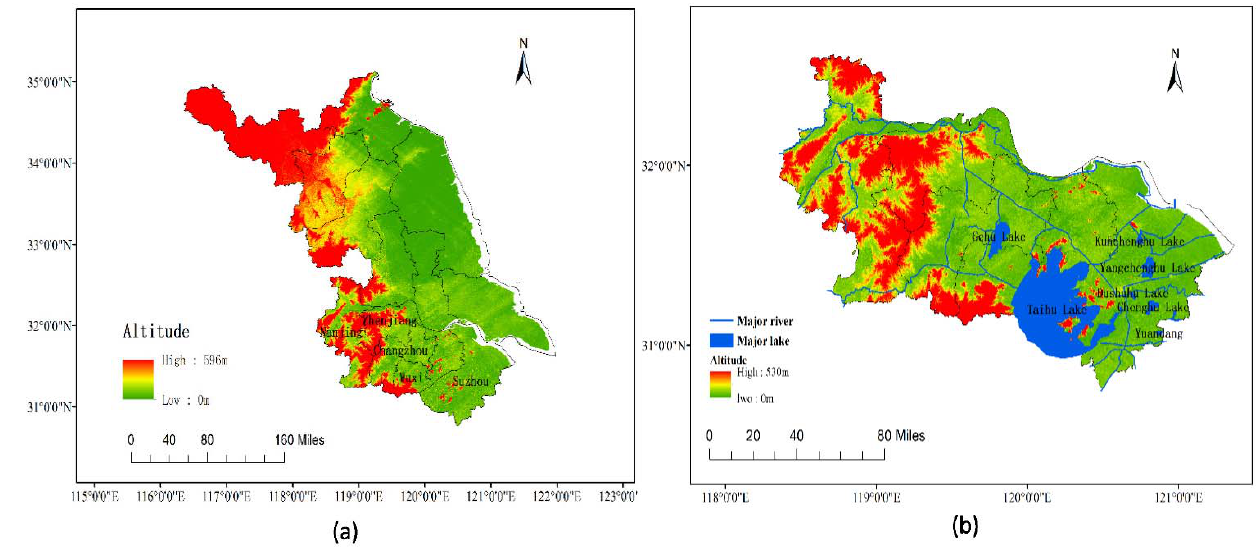
Figure 1. Locations of the research area: ( a ) locations of the five cities in Jiangsu Province; ( b ) locations of the major rivers and major lakes of Taihu Basin in the five cities.